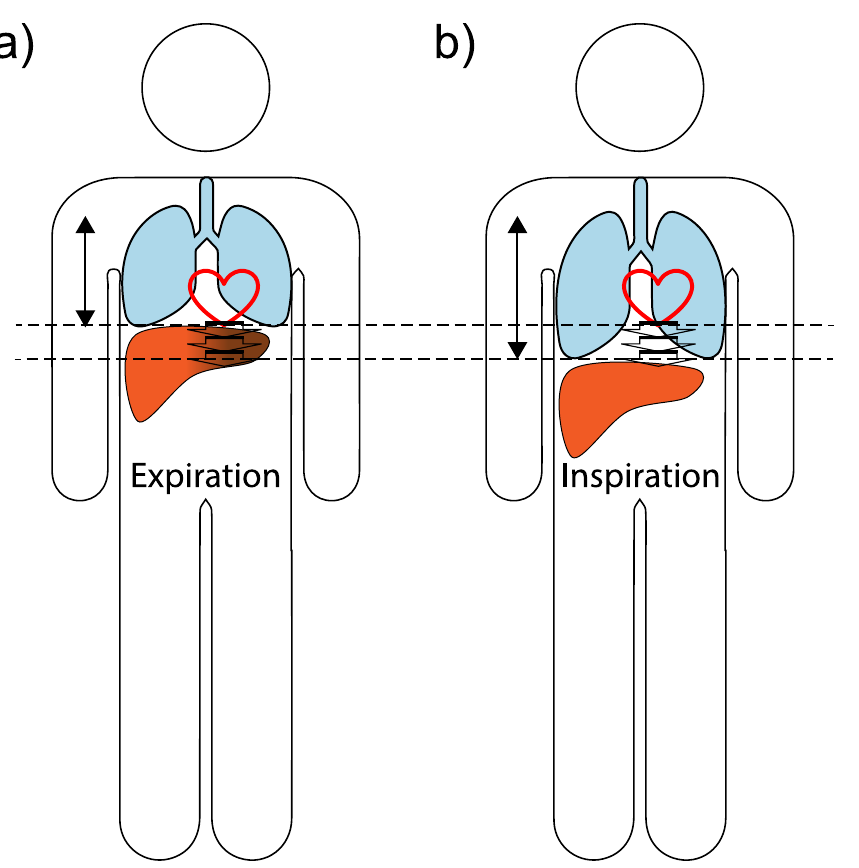
Fig 1. Visualization of the hypothesis underlying this study. a) Expiration: pulsation artifact present (signal void in the left liver lobe). b) Inspiration: reduced pulsation